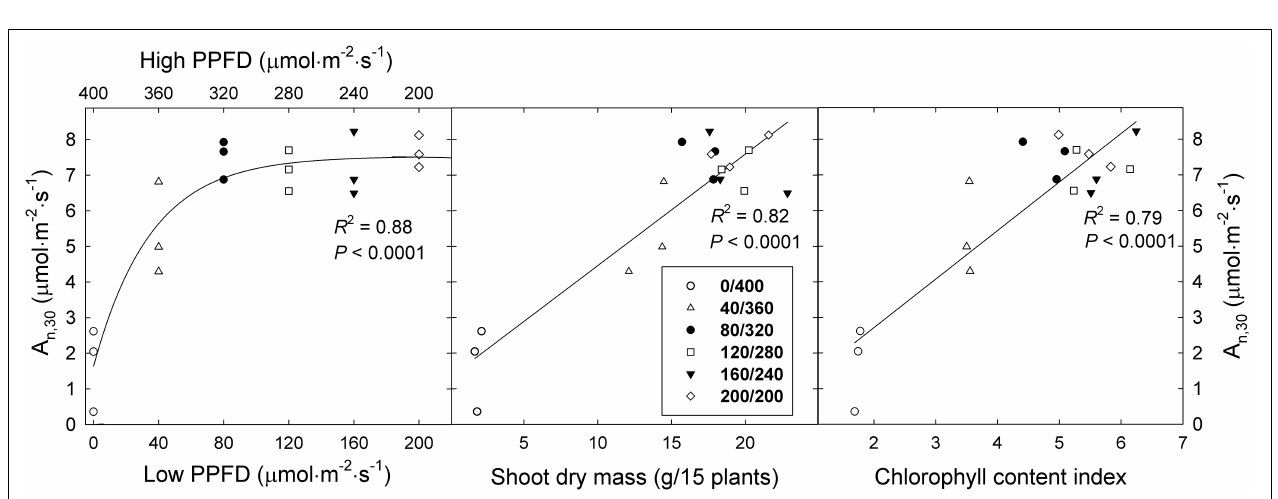
FIGURE 6 | Average net assimilation rate over 30 min (A n , 30 ) of ‘Green Salad Bowl’ lettuce ( Lactuca sativa ) as a function of fluctuating photosynthetic photon flux density (PPFD), total dry mass, and chlorophyll content index. Symbols represent data from each lighting treatment (three replications per treatment). Plants were grown under fluctuating PPFD, changing every 15 min between high and low PPFD ( ∼ 400/0, 360/40, 320/80, 280/120, 240/160, and 200/200 µ mol · m − 2 · s − 1 ).